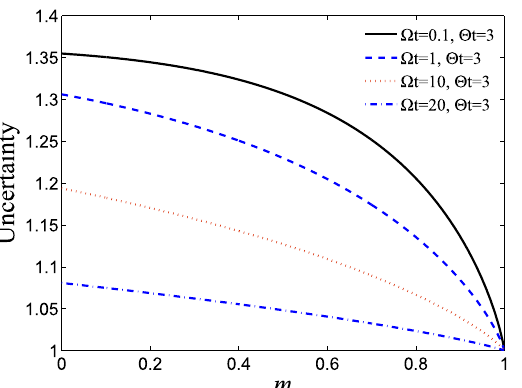
Figure 8. The entropic sum, S , is plotted as a function of the measurement strength ( m ) for different coupling x z , constant values, both Ω and Θ , for a fixed real initial states constructed with θ π = /3 and φ π = /6 . In the Figure, the black solid line, blue broken line, red dotted line and magenta dash-dotted line represent the following values of Ω Θ ( , ) : (0.1, 3), (1, 3), (10, 3) and (20, 3),